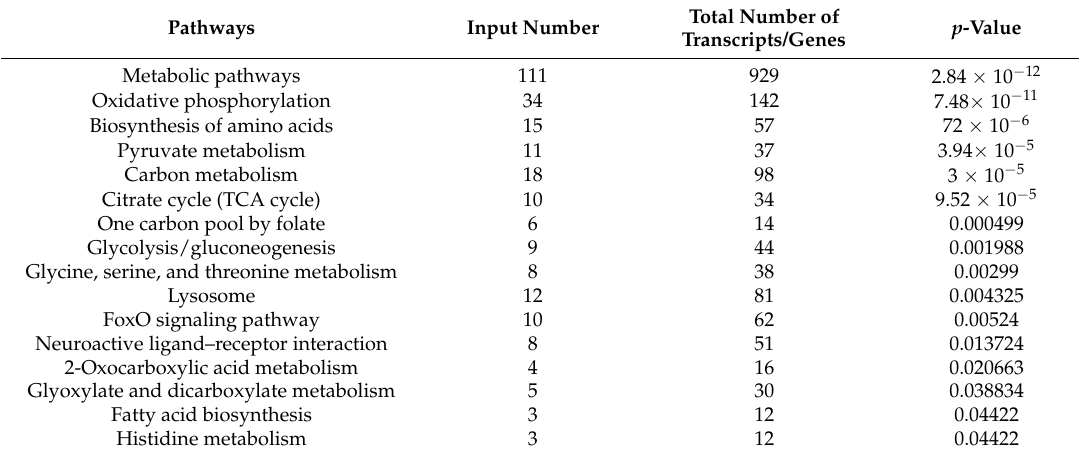
Table 6. Significant pathways of differentially regulated transcripts of